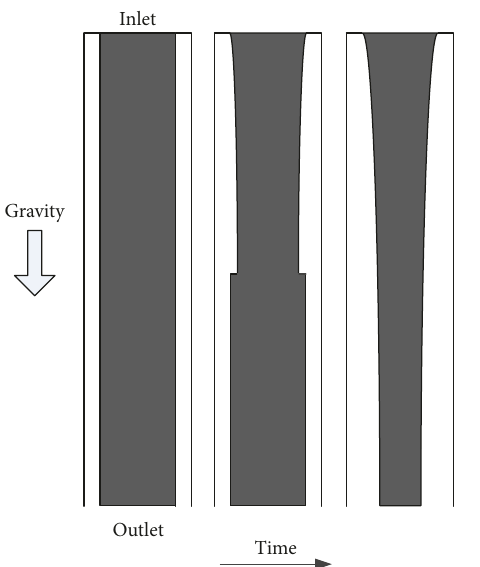
Figure 3: Illustration of the time evolution for the faucet flow prob- lem.